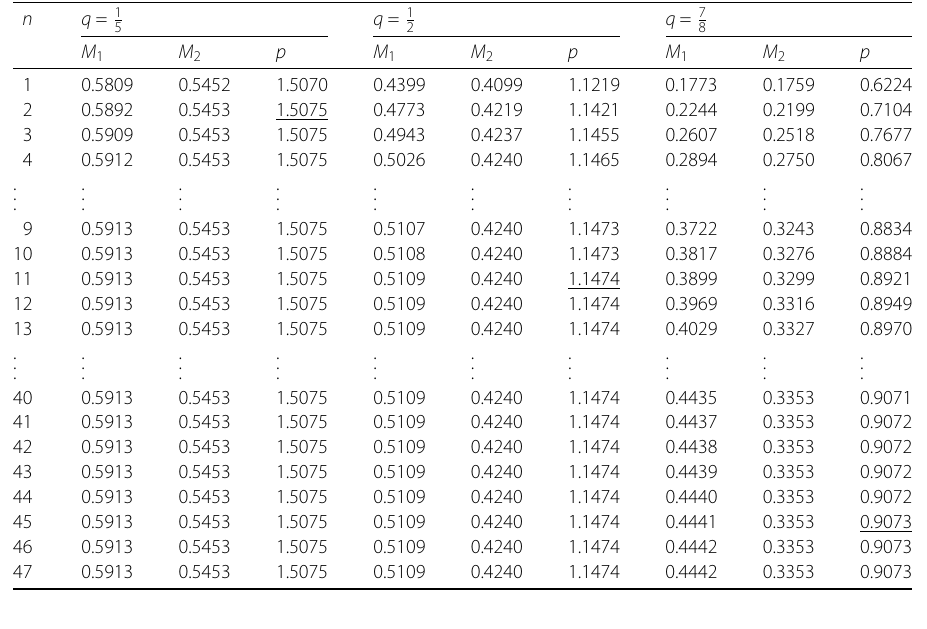
Table 3 Numerical results of M 1 , M 2 , and p = M 1 +